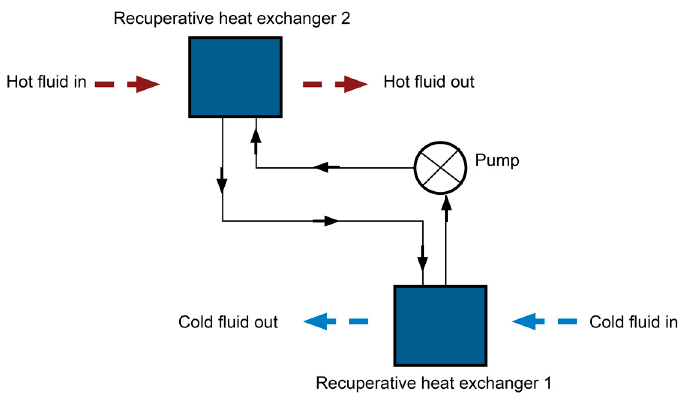
Figure 9. The working principles of run-around heat recovery Figure 9 . The working principles of run-around heat recovery [7] .